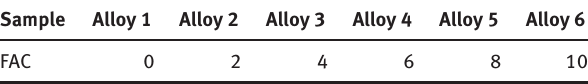
Table 1: FAC addition of the composites (wt.%).